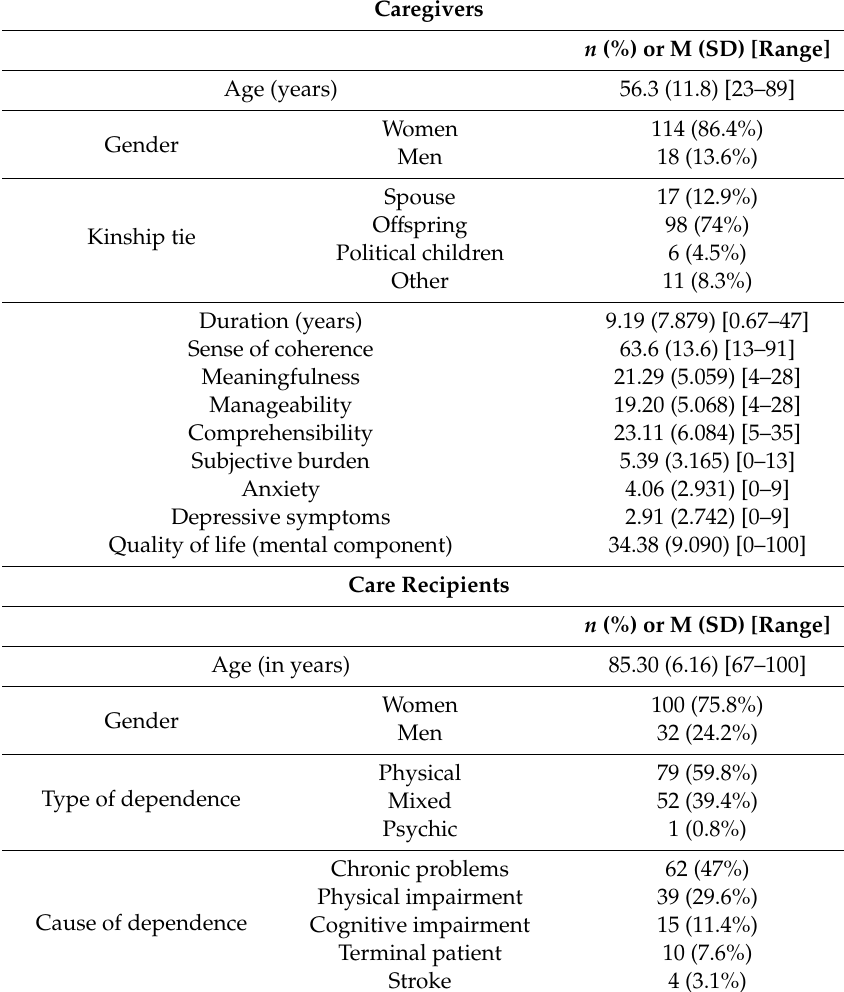
Table 1. Descriptive measures of the analyzed